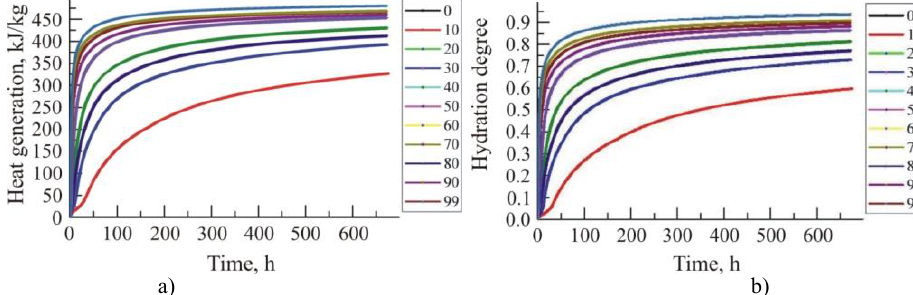
Fig. 1. Time dependences of heat generation (a) and hydration (b).